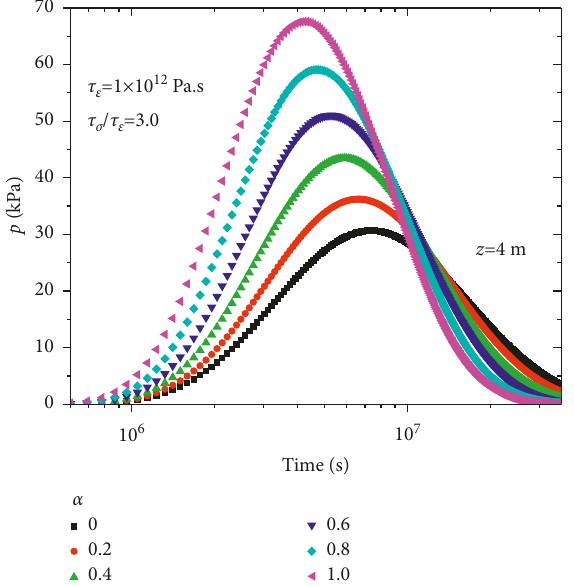
Figure 5: Influence of the order of the fractional derivative on excess pore pressure when τ